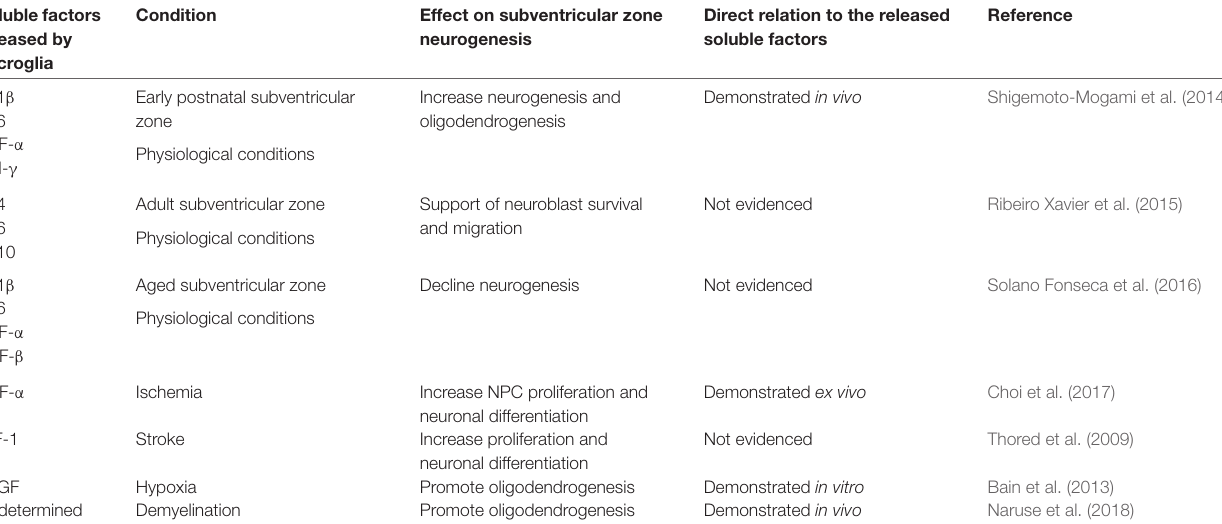
TABLE 1 | Soluble factors released by microglia in the subventricular zone (SVZ) in physiological and in pathological conditions. Soluble factors released by